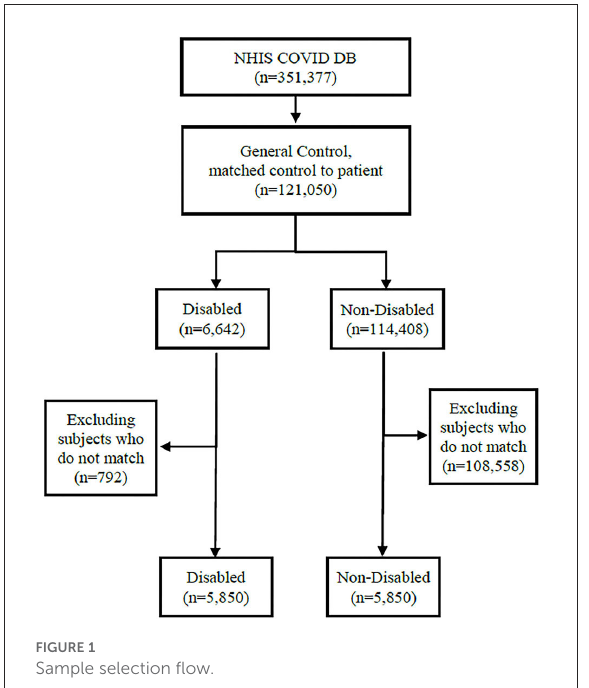
FIGURE1 Sample selection